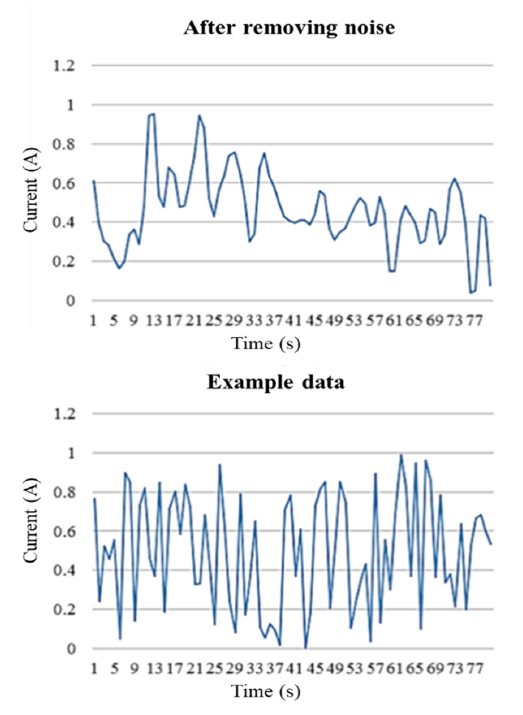
Figure 3. Filtering of a Wavelet